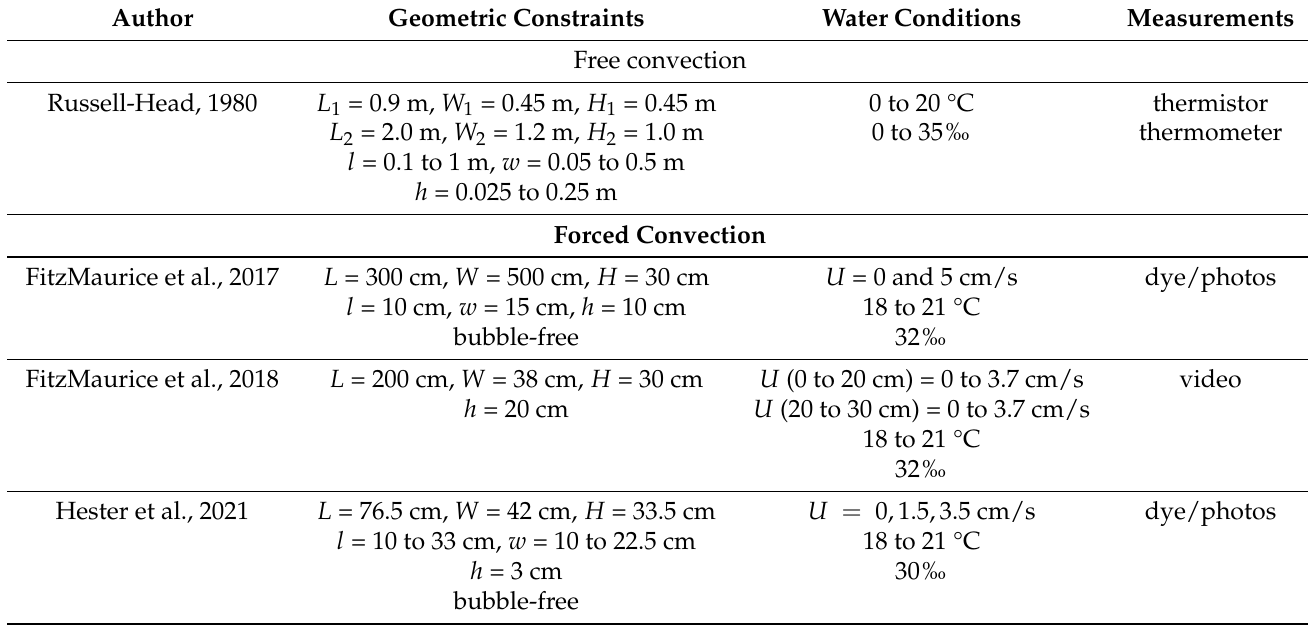
Table A5. Experiments focused on flow patterns and melting at the face of an ice block in both free and forced convection.